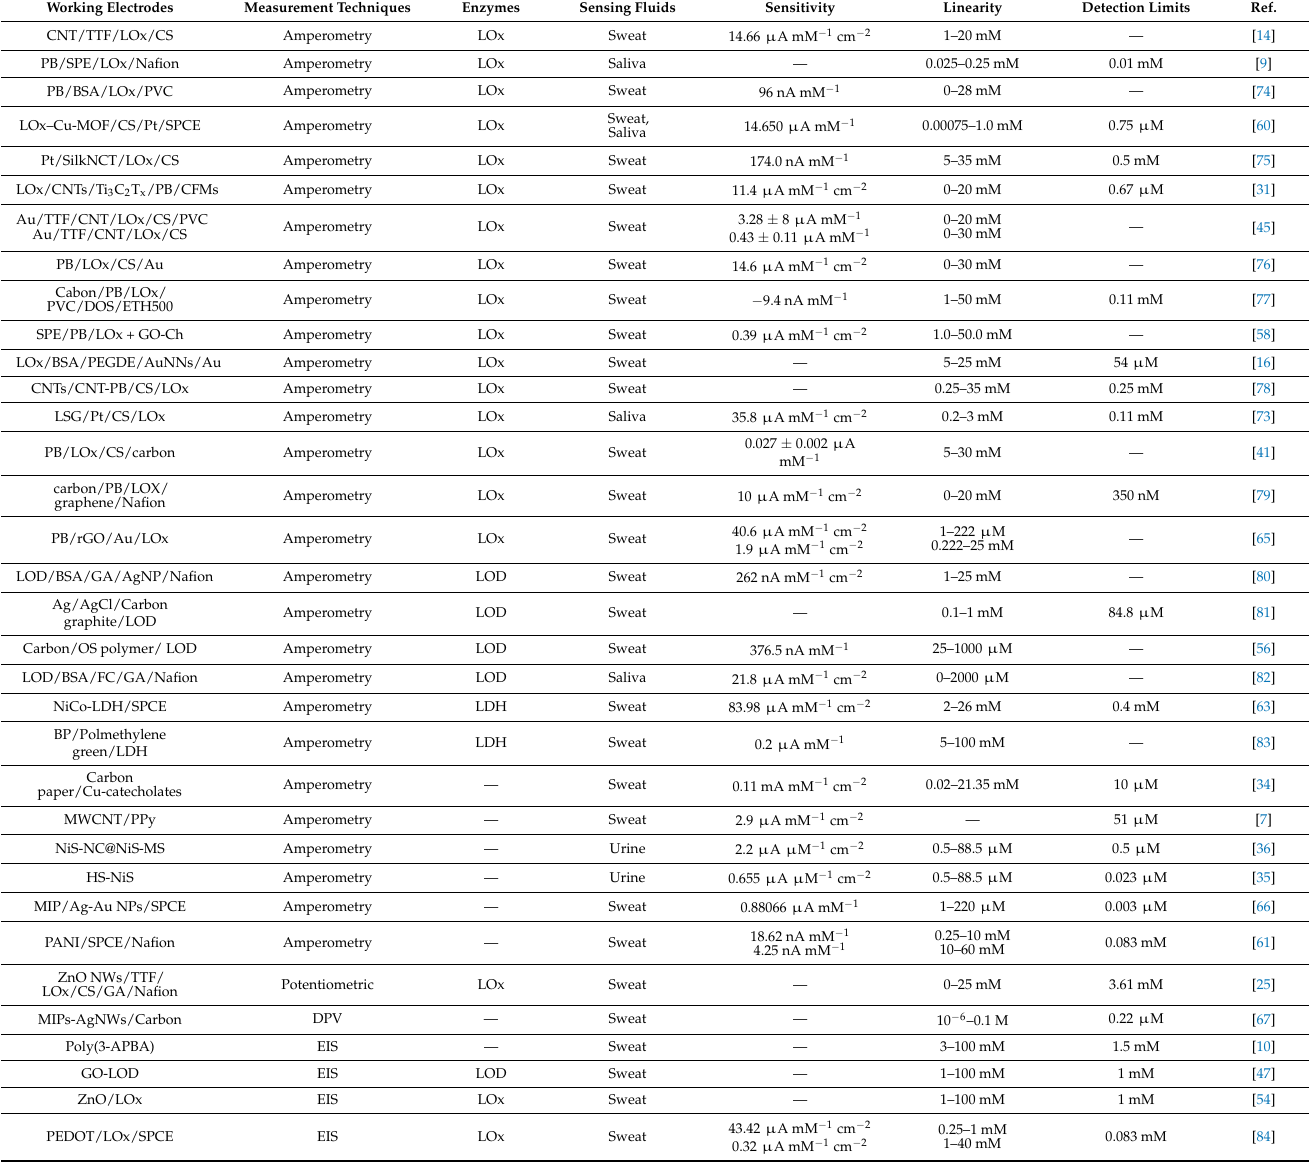
Table 1. Comparison of characteristics for various electrochemical lactate